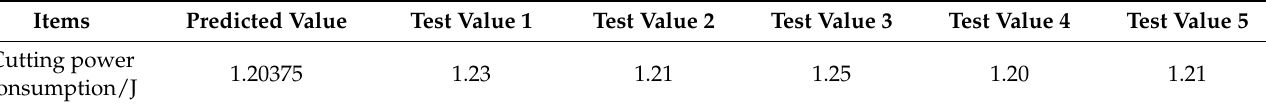
Table 5. Verification test